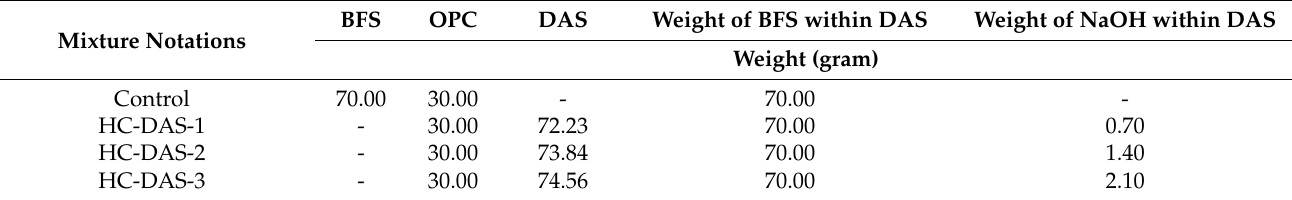
Table 3. Weights of BFS, OPC, and DAS within one-part